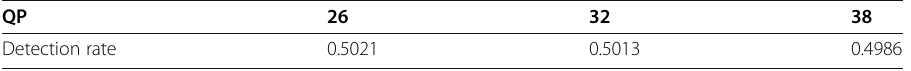
Table 13 The detection rate of Sheng ’ s method to test the proposed algorithm